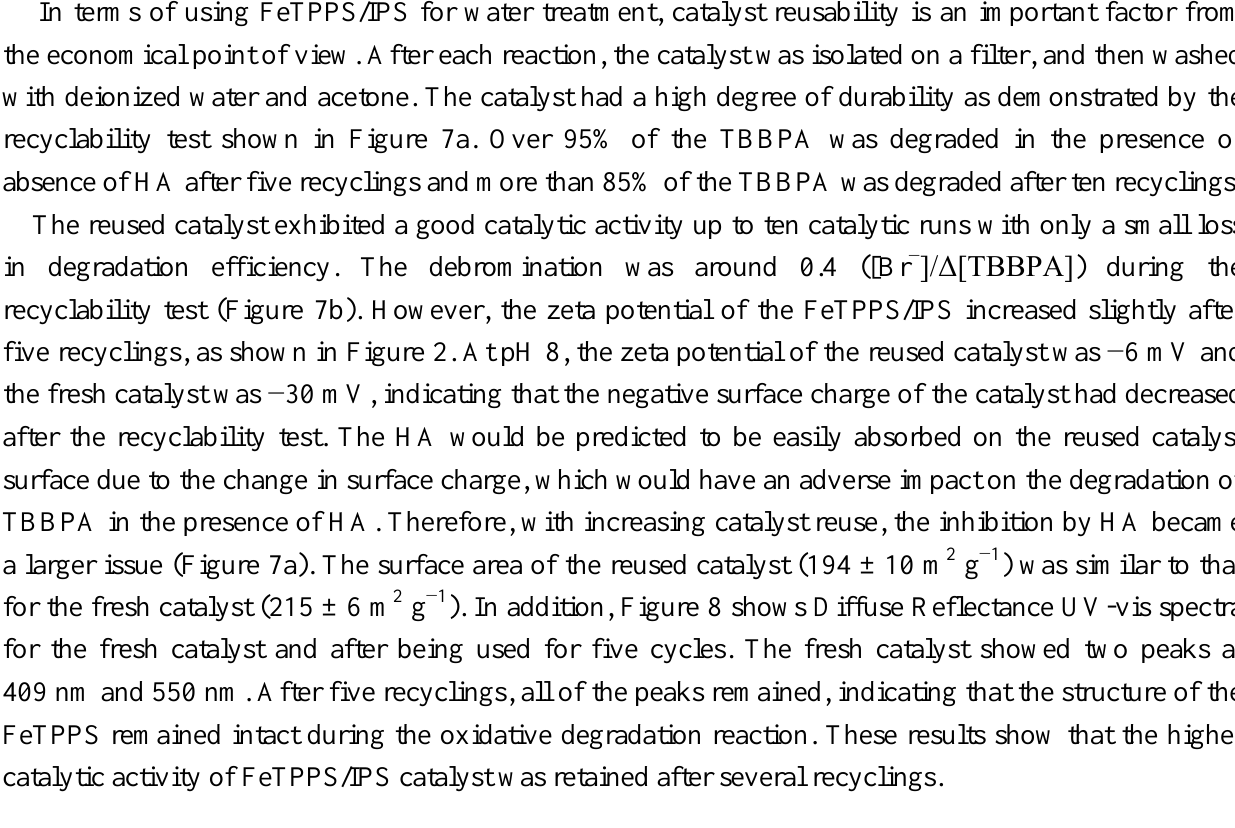
Figure 7. Reusability of the catalyst ( a ) TBBPA degradation, ( b ) number of bromide ions released. The reaction conditions were as follow: [TBBPA] , 50  M; [FeTPPS / IPS], 0 10  M (0.3 g L −1 ); [KHSO ], 1.0 mM; [HAs], 25 mg L −1 ; temperature, 25 °C; pH = 8; 5 reaction time, 4 h (in the absence of HA), 20 h (in the presence of